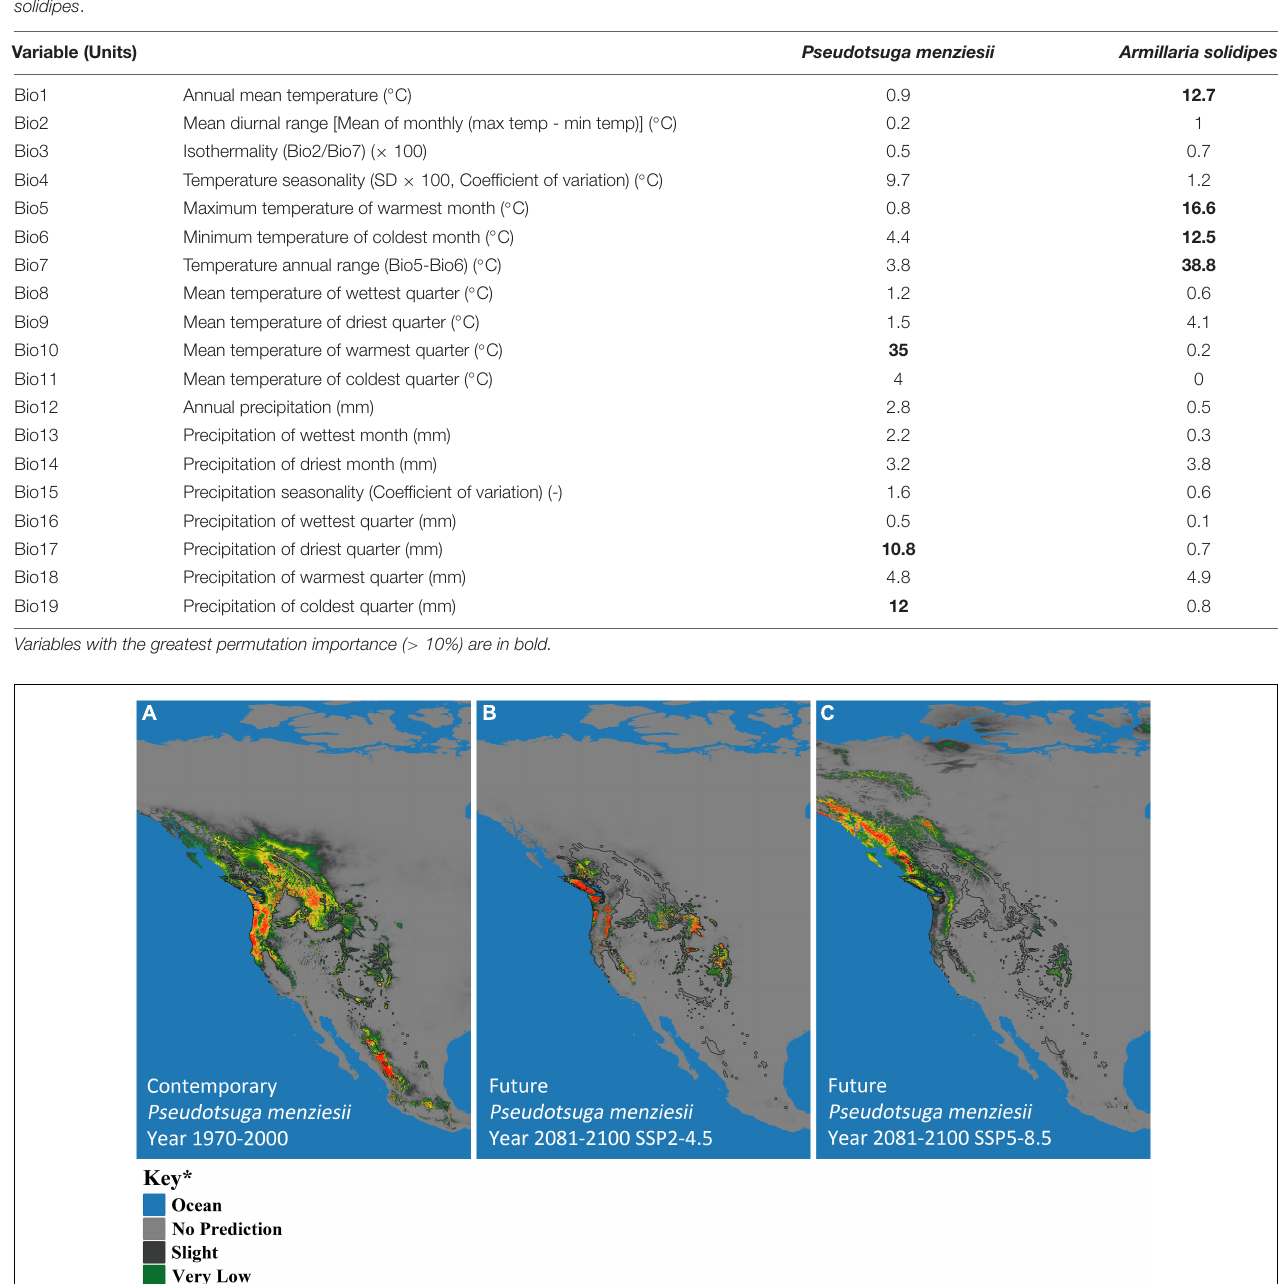
TABLE 1 | Summary of MaxEnt’s permutation importance value for each of the contemporary 19 bioclimatic variables (Bio1–Bio19) derived from the WorldClim (worldclim.org) database (1970–2000) used to model suitable climate space (potential distribution) based on occurrence points of Pseudotsuga menziesii and Armillaria solidipes .